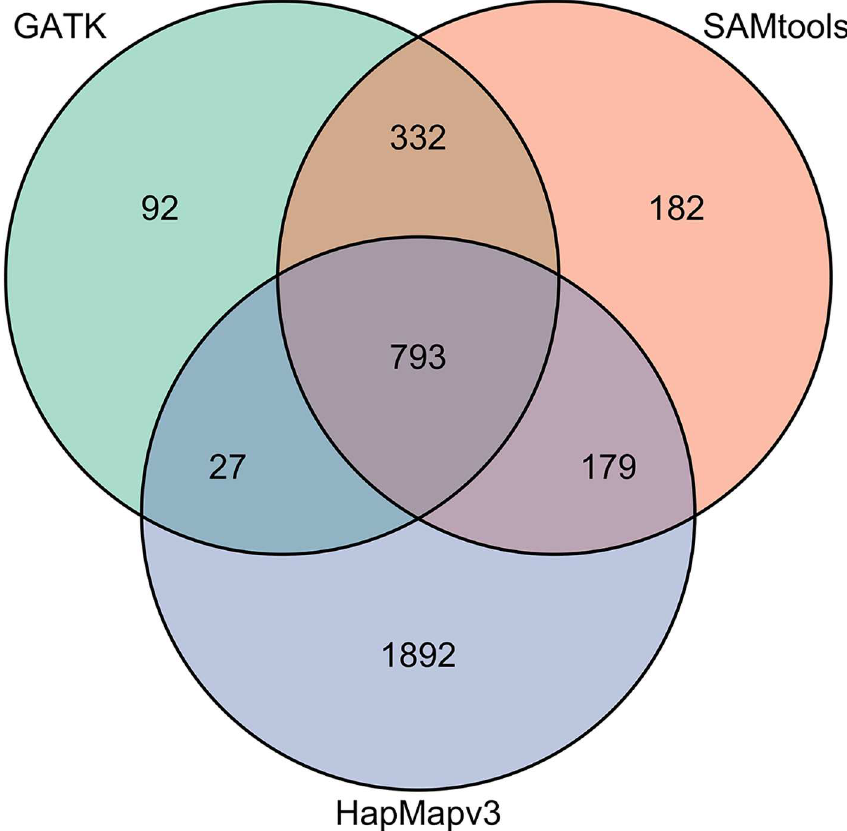
Fig 3. Venn diagram comparing different SNP datasets. Venn diagram representing the relationships amongSNPs called using GATK and SAMtools, and the HapMap3SNPs in the same genomicregions. Novel variants are those uniqueto the GATK and SAMtools